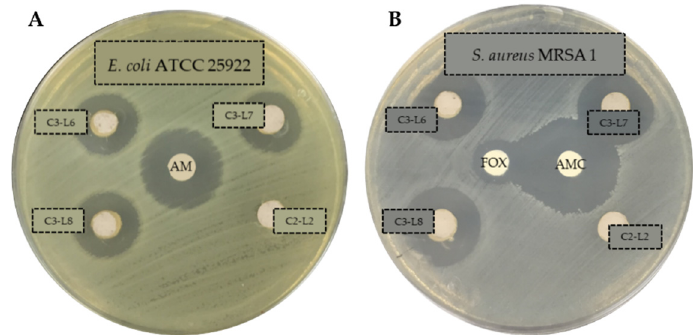
Figure 1 . Antibiograms of C3 (with silver, batches L6, L7 and L8) and C2 (without silver, batch L2) products against E. coli ATCC 25922 ( A ) and S. aureus MRSA 1 ( B ). C3 and C2 products in solution 50 mg/mL. Ampicillin (AM, 10 µg), Amoxicillin/Clavulanate (AMC, 30 µg), cefoxitina (FOX, 30 µg).